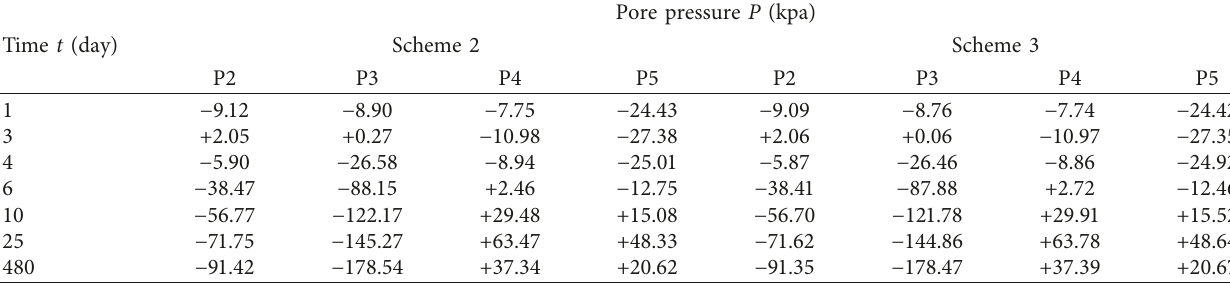
Table 3: Variation of pore pressure at P2–P5 with time in Scheme 2 and Scheme 3.